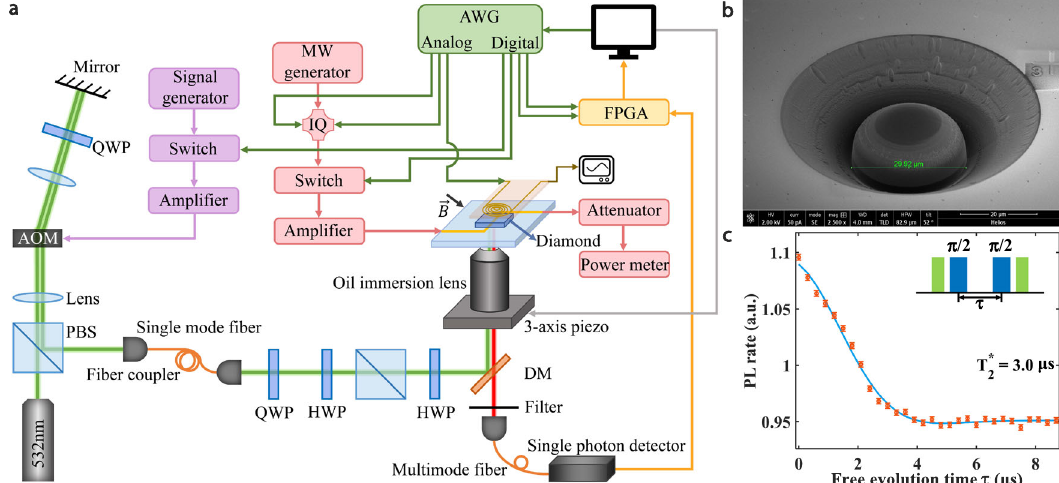
Fig. 4 The diamond sample and experimental setup. a Schematic diagram of our experimental setup. b Image of a solid immersion lens (SIL) under scanning electron microscope (SEM). The SIL is fabricated by the focused ion beam (FIB). c We measure the dephasing time of the electron spin via standard Ramsey interferometry. The experimental data (red circle) is fi tted with f ð τ Þ ¼ a þ b cos ð δ t þ φ Þ exp ð(cid:3)ð τ = T (cid:5) 3 : 0 μ s blue line), giving T (cid:5) 2 ¼